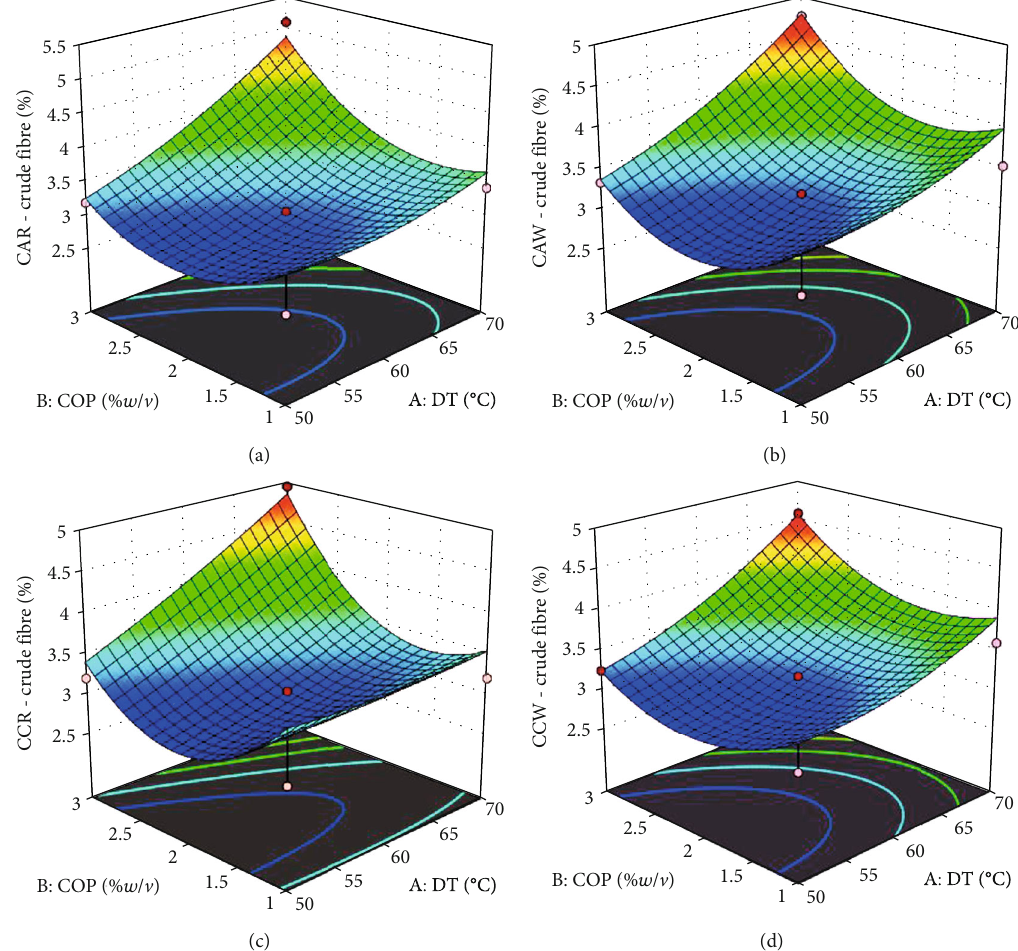
Figure 4: Response surface plots for crude fi bre content of cassava fl our. (a) Cassava from red landrace pretreated with citric acid. (b) Cassava from white landrace pretreated with citric acid. (c) Cassava from red landrace pretreated with calcium chloride. (d) Cassava from white landrace pretreated with calcium chloride. DT — drying temperature ( ° C); COP — concentration of pretreatment (% w / v